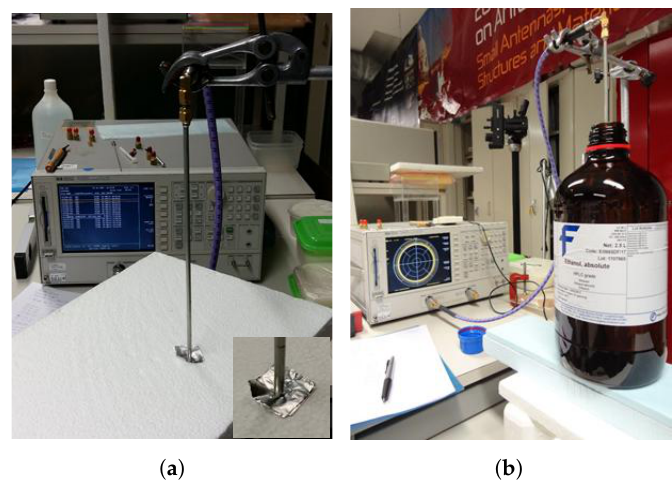
Figure 8. Experimental setup used for the measurements. The photographs show two examples, the short-circuit and a reference liquid. ( a ) Short-circuit. ( b ) Liquid.